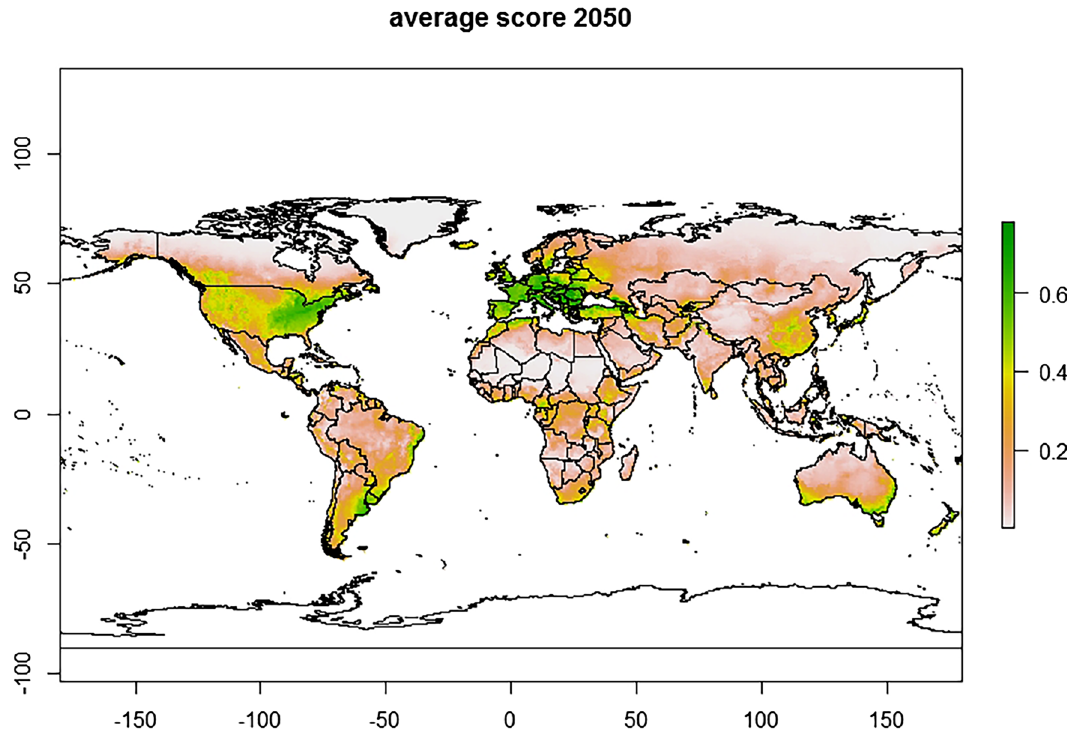
Figure 7. Maxent and BIOCLIM average model plots depicting future changes in the establishment of Trialeurodes vaporariorum. Prediction is up to year 2050 showing increase in risk of Trialeurodes vaporariorum establishment (ERI > 0.4–0.6) probably due to the rising temperatures attributed to global